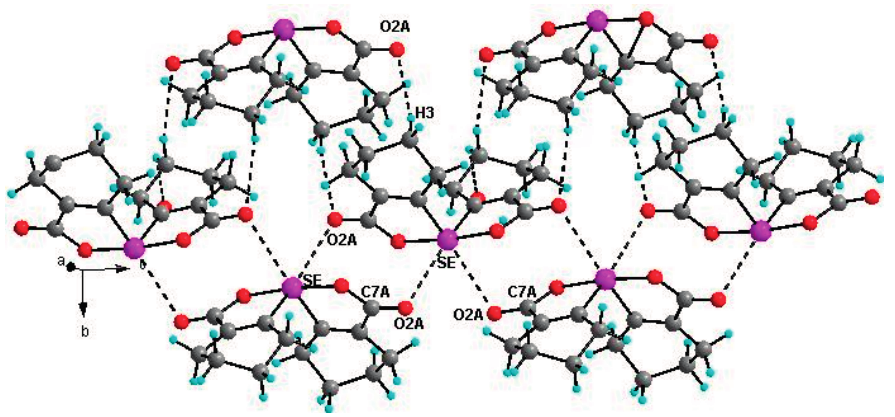
Figure 6. Two-dimensional packing diagram of compound 20 O2A···Se 3.053(2) Å, C7A–O2A–Se 102.8(2)°, O2A···H3 2.609(2) Å, C3A–H3–O2A